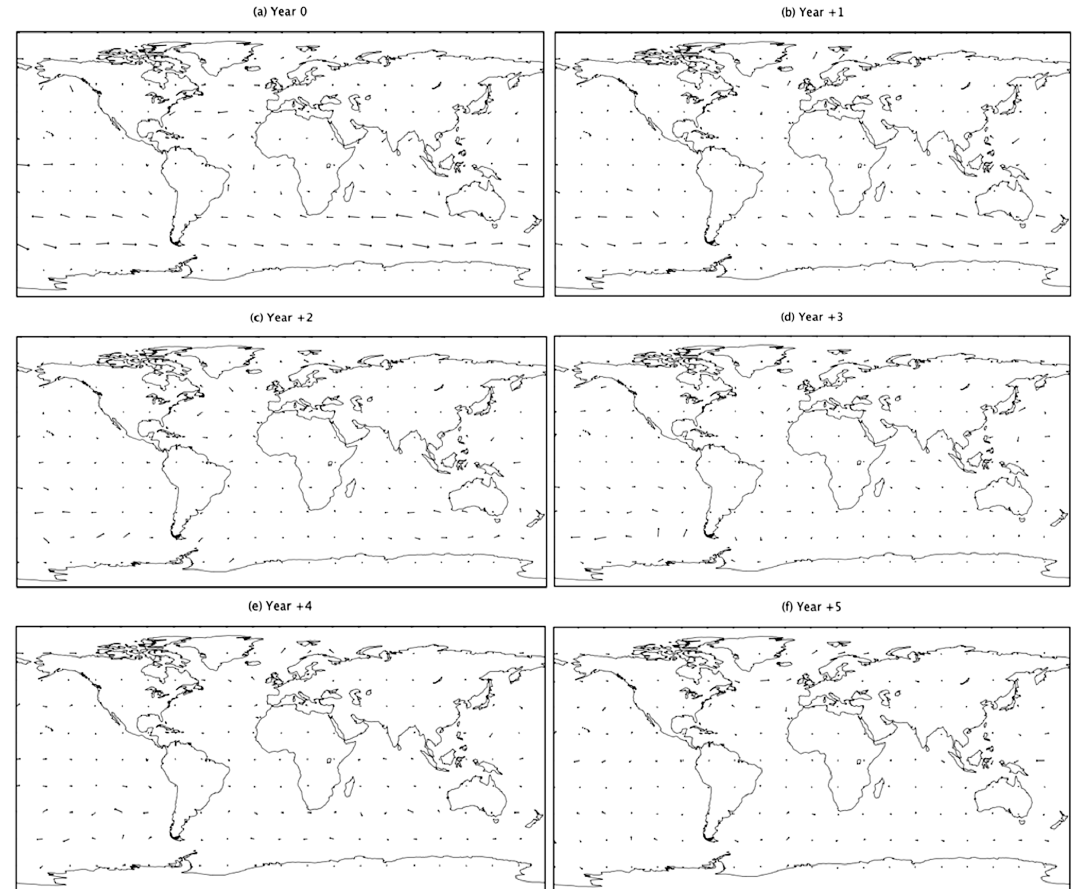
Figure 13. Global surface wind direction anomalies in response to the Crowley and Unterman (CR) forcing, showing multi-ensemble mean responses over JASON averaged across all analysed eruptions for years 0 to + 5 after